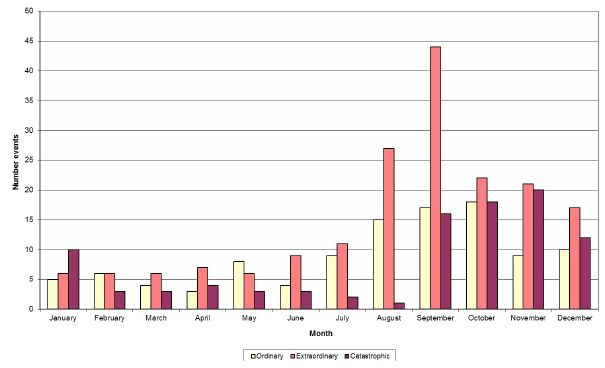
Fig. 3. Monthly distribution of flood events by region for the period